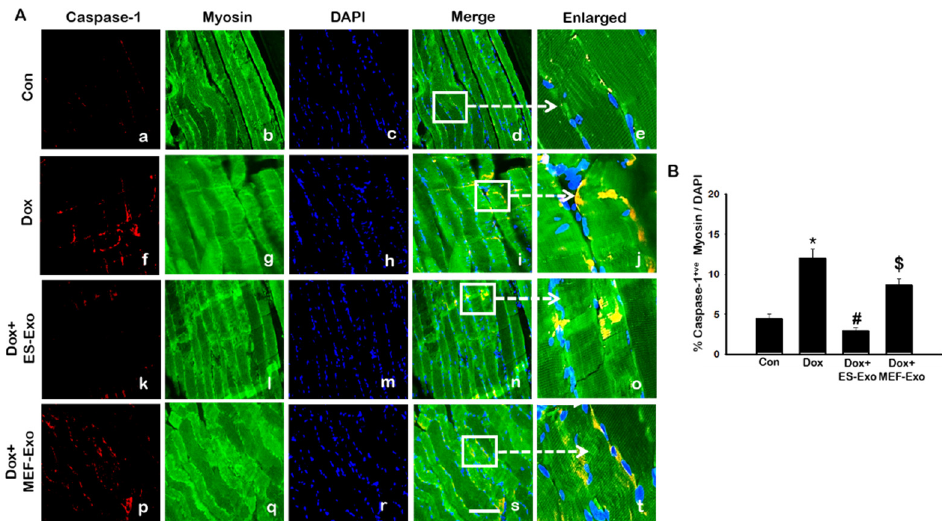
Figure 5. Treatment with ES-Exos reduces Dox-induced caspase-1 cascade. ( A ) Representative photomicrographs of soleus muscle sections stained with myosin and pyroptotic marker, caspase-1. Each box shows caspase-1 + cells in red ( a , f , k , p ), myocytes in green ( b , g , l , q ), DAPI in blue ( c , h , m , r ), merged images ( d , i , n , s ), and enlarged areas of merged images ( e , j , o , t ). ( B ) Histograms from quantitative analysis of caspase-1 + cells over total DAPI. Error bars = mean ± S.E.M. * p < 0.05 vs. control, # p < 0.05 vs. Dox, $ p = non-significant vs. Dox, one-way ANOVA followed by Tukey test; Scale bar = 100 µm, n = 14–16, male and female. Images taken at 40 × magnification.